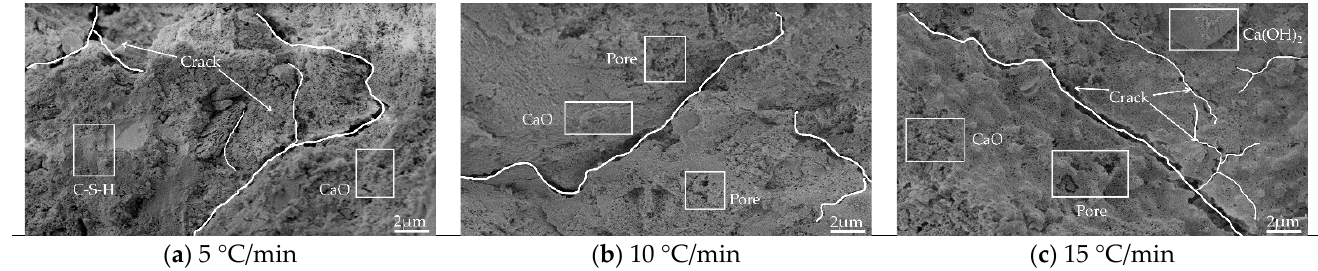
Figure 11. Microtopography and pore structure images of mortar heated (600 °C): ( a ) 5 °C/min; ( b ) 10 °C/min; ( c ) 15 °C/min.